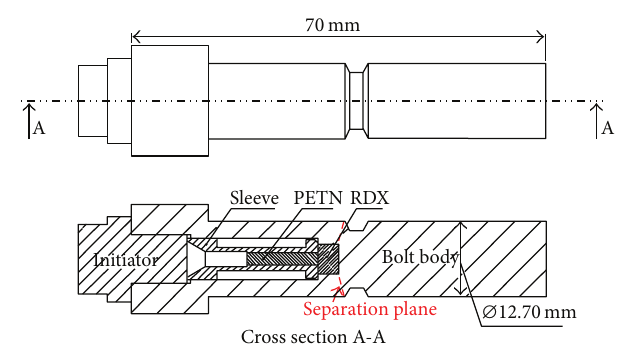
Figure 2: Diagram of the ridge-cut explosive bolts.